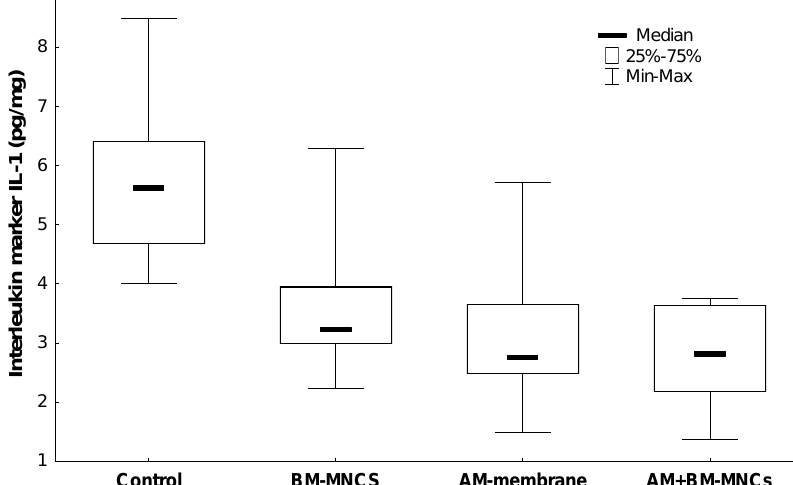
Figure 5. Effect of AM and BMSCs on Interleukin marker IL-1. Results are expressed as mean [interquartile range] ± SEM (N = 10). p < 0.05 denoted statistical significance in comparison to the control group. BMSCs: Bone Marrow Mesenchymal Stem Cells; AM : acellular human amniotic